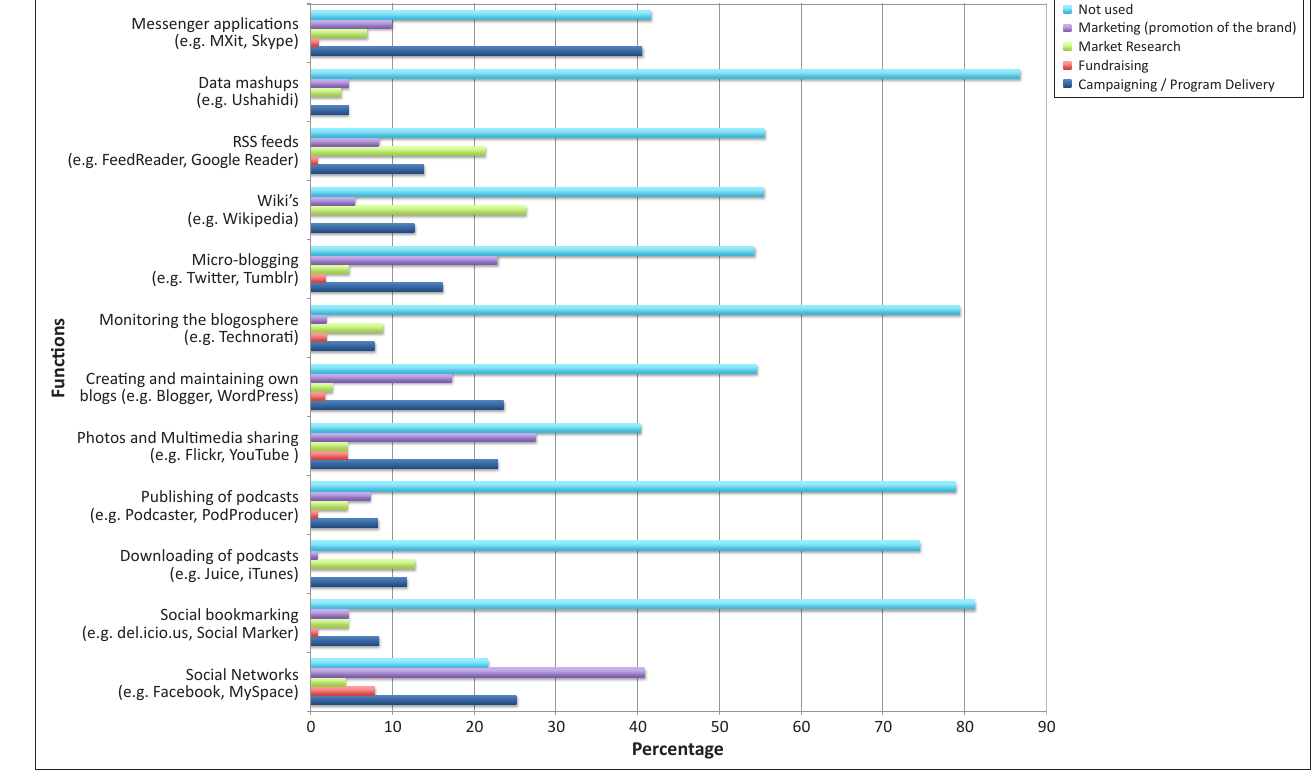
FIGURE 3: Functions of Web 2.0 usage in South African civil society organisations. TABLE 3: Cumulative adoption versus cumulative areas of usage. Social media